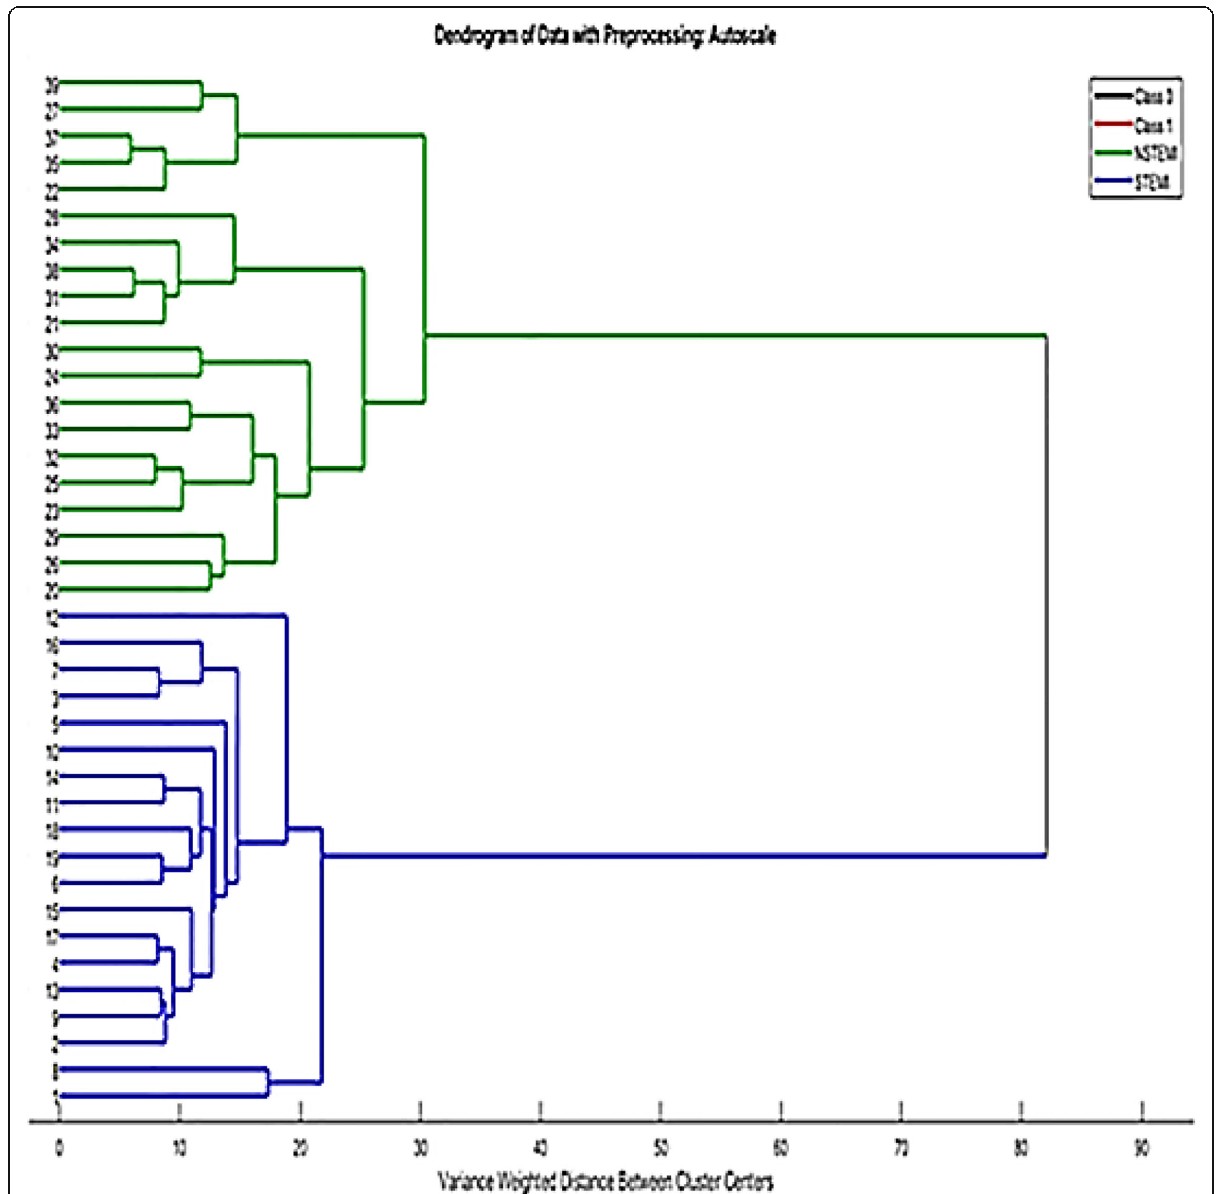
Fig. 4 Dendogram was monitored for NSTEMI (green) vs STEMI patients